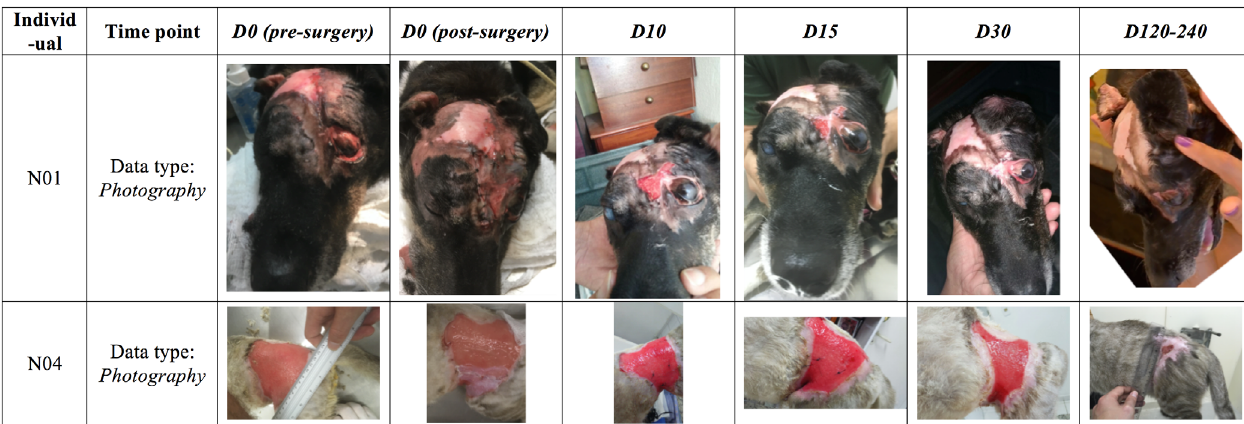
Figure 5. Photographs of areas treated with the biomembrane. In patient N01, old fibrotic scar tissue was removed surgically and two biomembranes applied and sutured to adjacent tissue. By time point D30, the wound had fully healed. In patient N04, only part of the lesion (approximately 1/3) was treated on D0 with the biomembrane (as seen in the D0 post-surgery photograph). The non biomembrane-treated area (without biomembrane in the D0 post-surgery photograph) had in fact been treated with another wound dressing two weeks before,